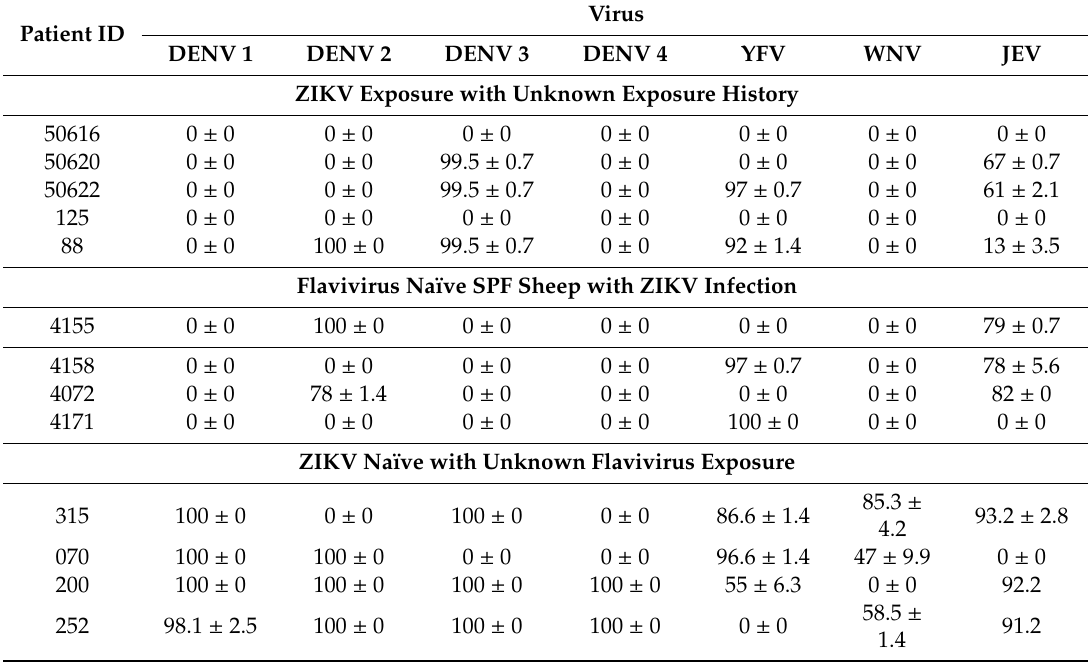
Table 2. Cross neutralization of flaviviruses by subjects with and without ZIKV exposure. Data denotes average neutralization ± standard